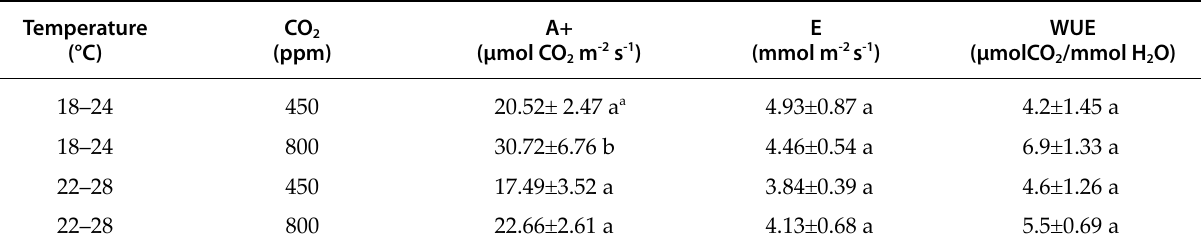
Table 5. Mean assimilation (A), transpiration rate (E), and water use efficiency (WUE) in 2nd leaves of zucchini plants grown in different temperature and CO 2 regimes. Data are shown as means of three trials.